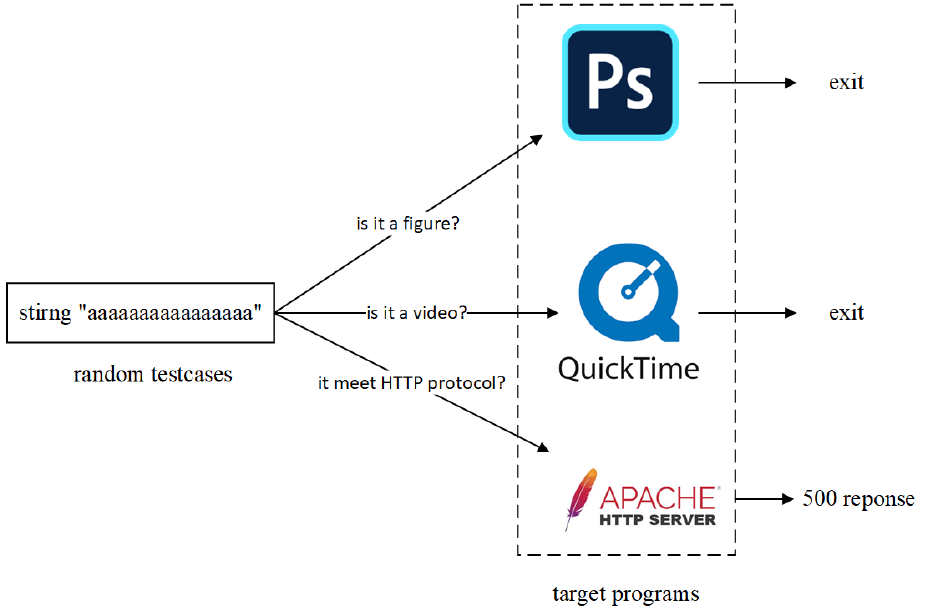
Figure 1 . Completely randomly generated test cases cannot pass format